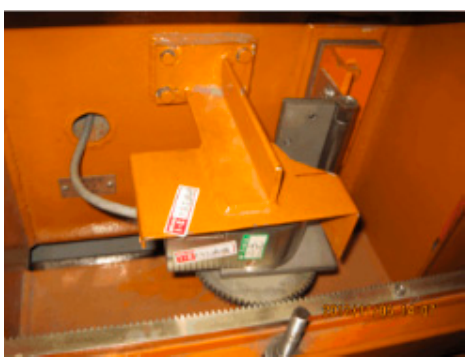
Figure 2. The rack and pinion positioning system.